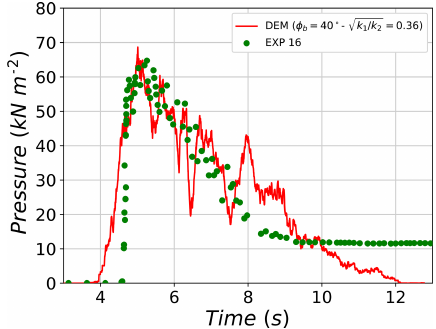
Figure 22. The best-fitting set of parameters ( each of the selected experimental tests based on comparison of flow height, mean front velocity and maximum applied